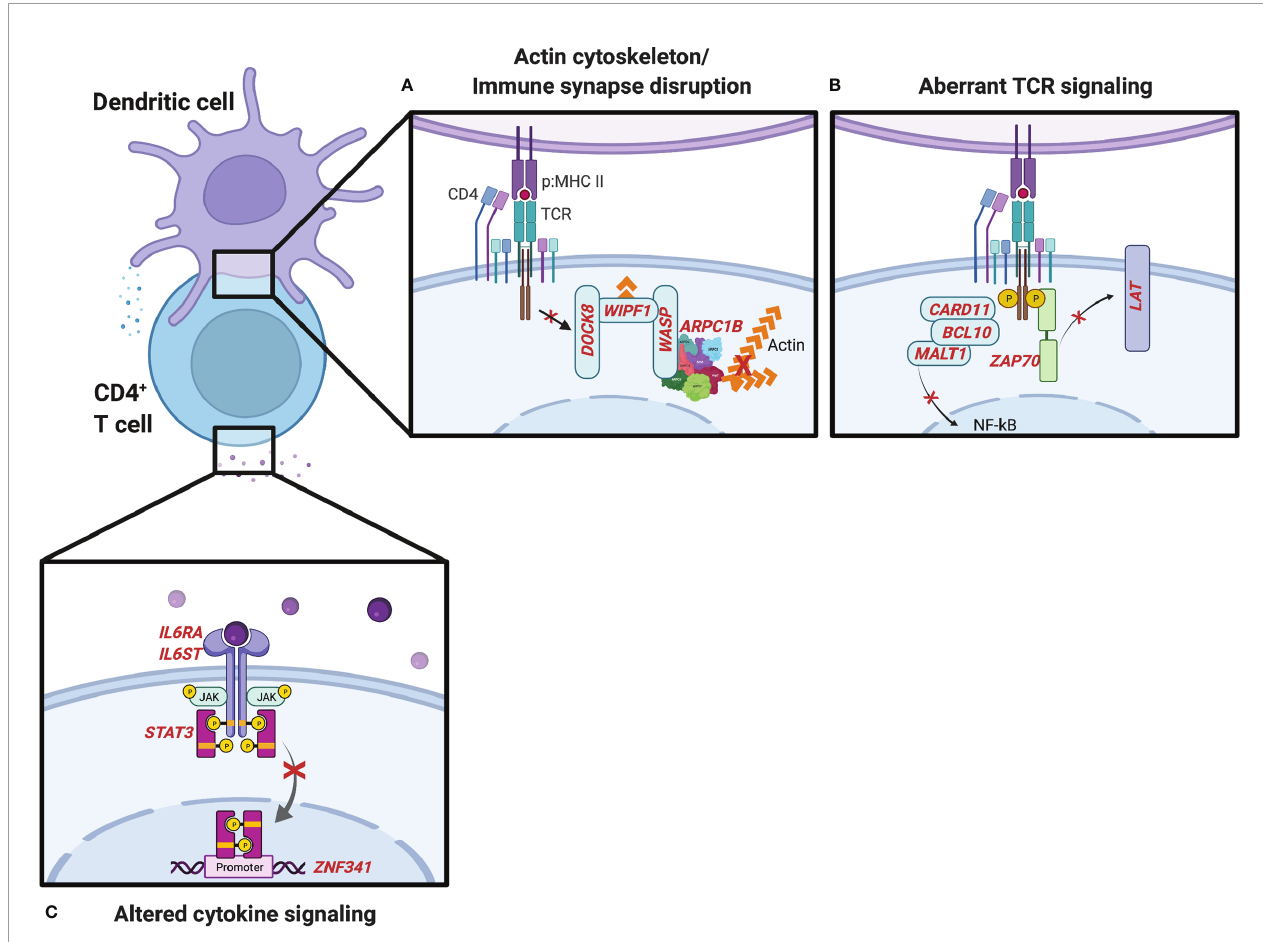
FIGURE 2 | IEI in fl uencing CD4 + T-cell activation and differentiation. (A) Genes noted in red involved in the actin cytoskeleton and formation of the immunological synapse. (B) T-cell receptor (TCR) signaling genes in fl uence the generation of Th2 cells and type 2 in fl ammation. (C) IEI associated with the IL-6-STAT3 cytokine signaling